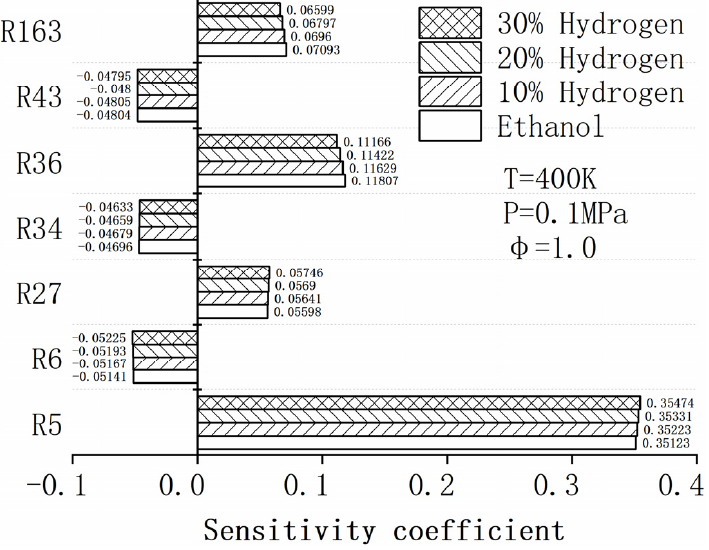
Figure 12. Flow rate sensitivity influenced by hydrogen composition (T0 = 400 K, P0 = 0.1 MPa, φ = 1).